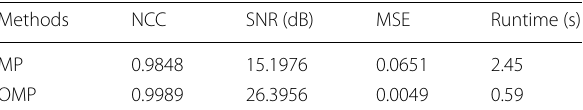
Table 1 The denoising performance of the MP and OMP methods Methods